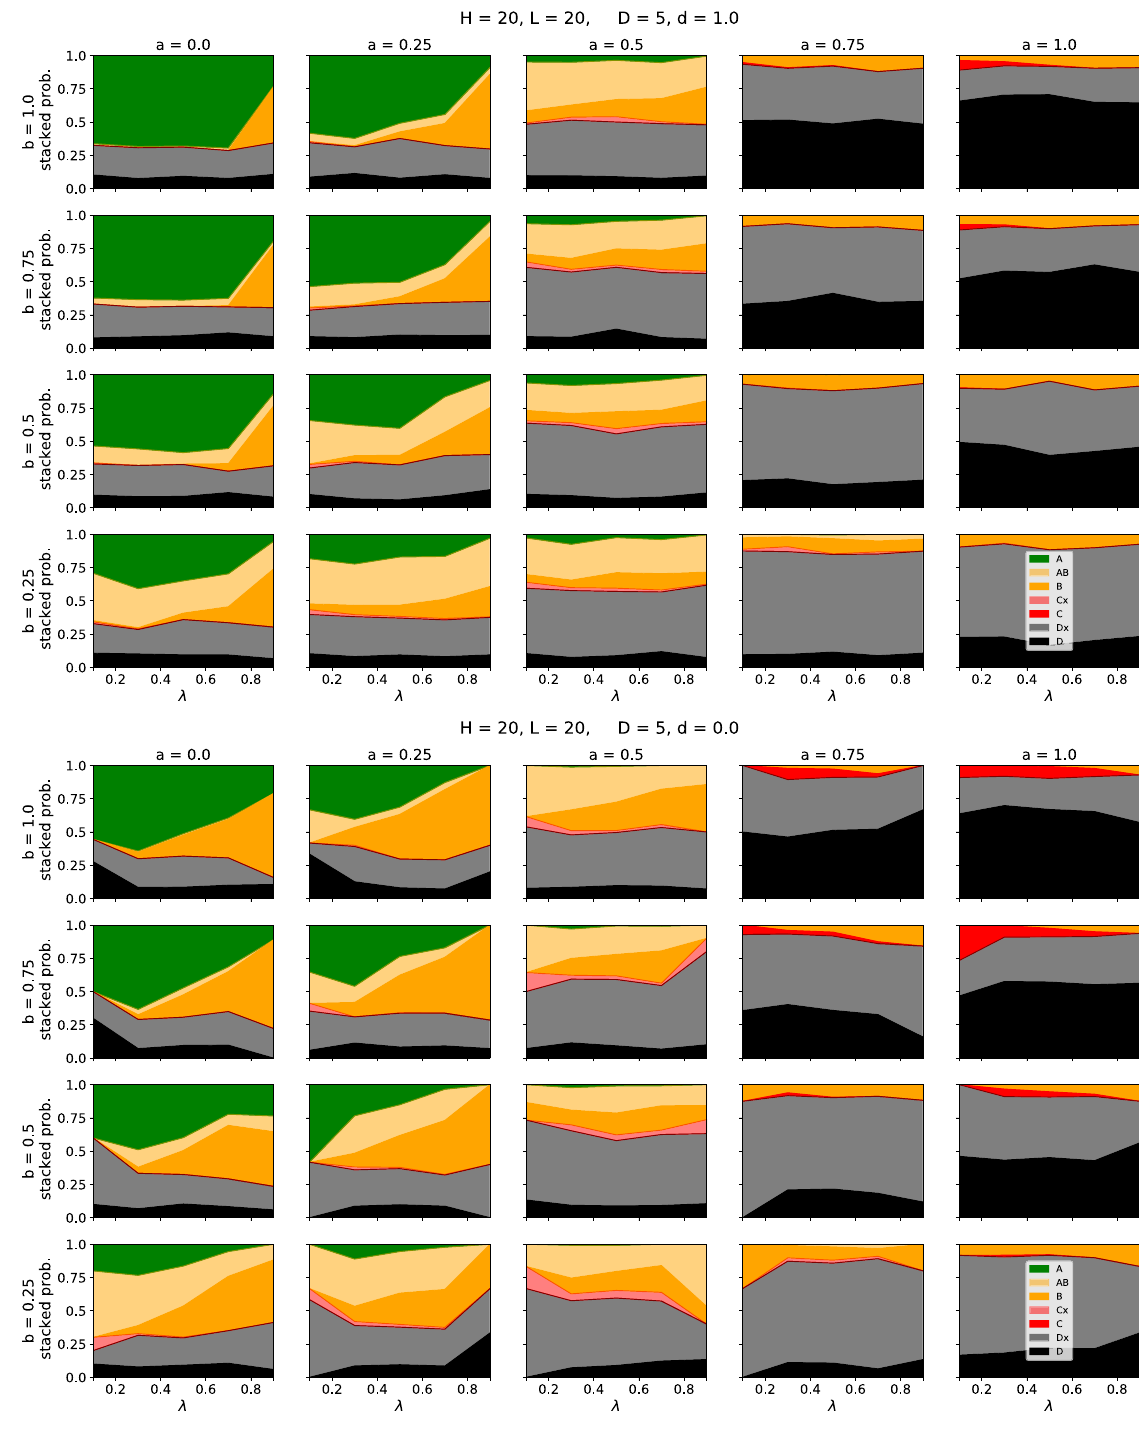
Figure 5. Dependence of the observed cases on the average position (cid:31) of inactive nodes. The colour code (as defined in Fig. 1a) indicates, which cases occurred in the time line. For the upper figure, the clustering parameter was set to d = 1 which means that all defective nodes form one cluster. Contrarily, in the lower figure, the parameter was set to d = 0 , leading to a random distribution of the defective nodes. Results for other sets of parameters are provided in the